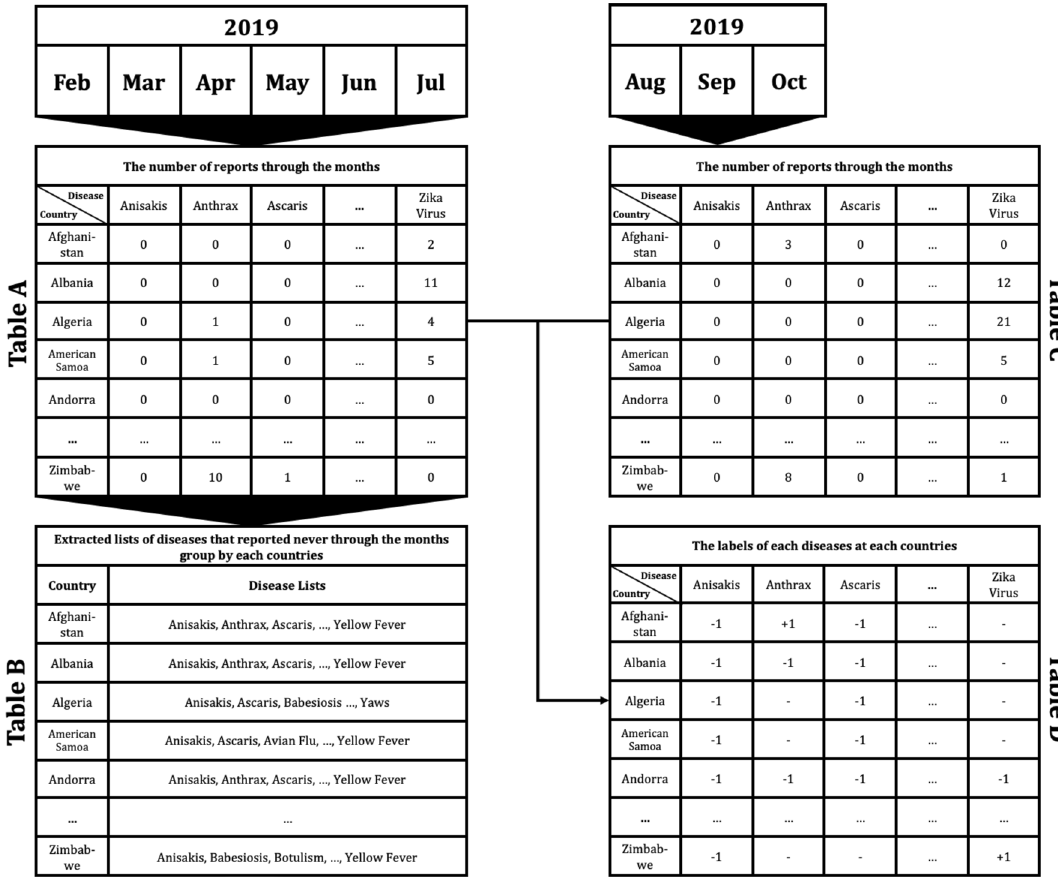
Figure 4. Example of data preprocessing to predict infectious disease outbreak for 3 months after July 2019, using report count data from February to July 2019: Table A indicates the number of reports concerning each disease in each country from February to July 2019. Table B shows the lists of diseases that reported none during the 6 month period February to July 2019 in each country. Table C shows the number of counted reports related to listed diseases in each country from August to October in 2019. Finally, Table D shows the labels of each disease for each country. ‘ + 1 ′ indicates that the disease occurred in the country between August and October; in contrast, ‘ − 1 ′ indicates that the disease did not occur, while ‘ − ’ means that the disease had already occurred during the period February to July, thus the disease for the country does not display a